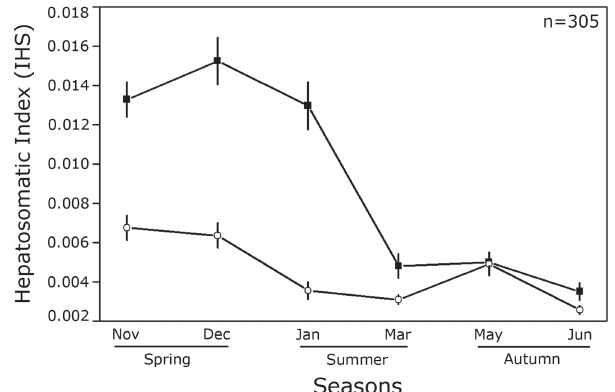
Fig. 8. Mean values (± standard error) of the hepatosomatic index among months and seasons (black square = females; white circle = males) of Cetengraulis edentulus in Guanabara Bay.